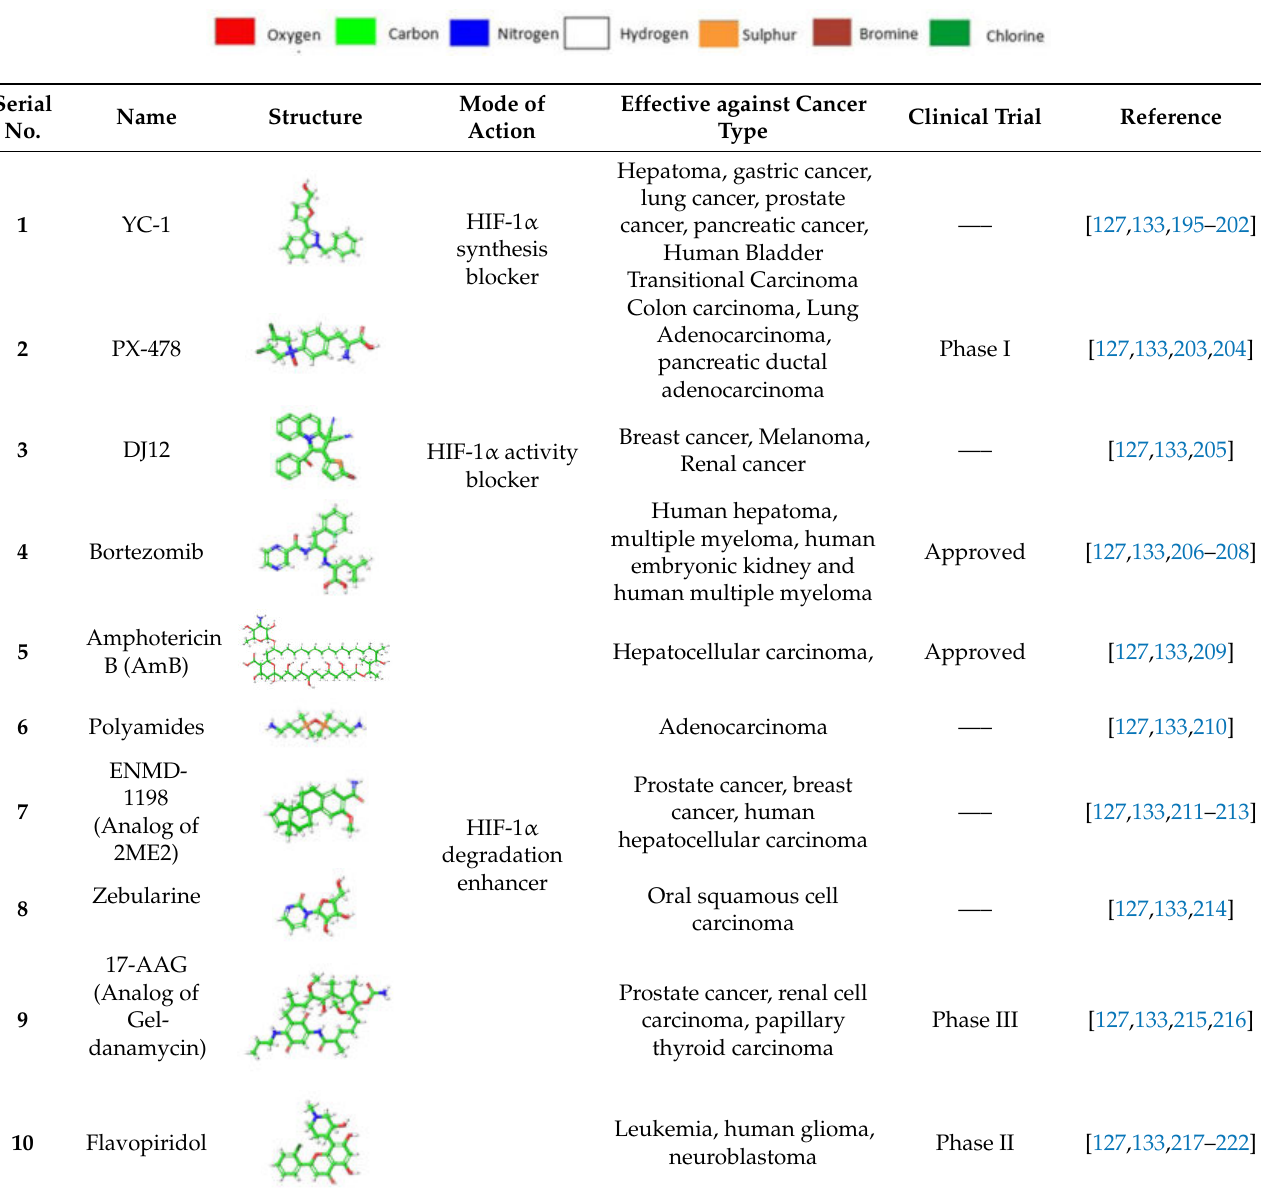
Table 2. List of various potential synthetic HIF-1 α inhibitors based on their mode of action in different